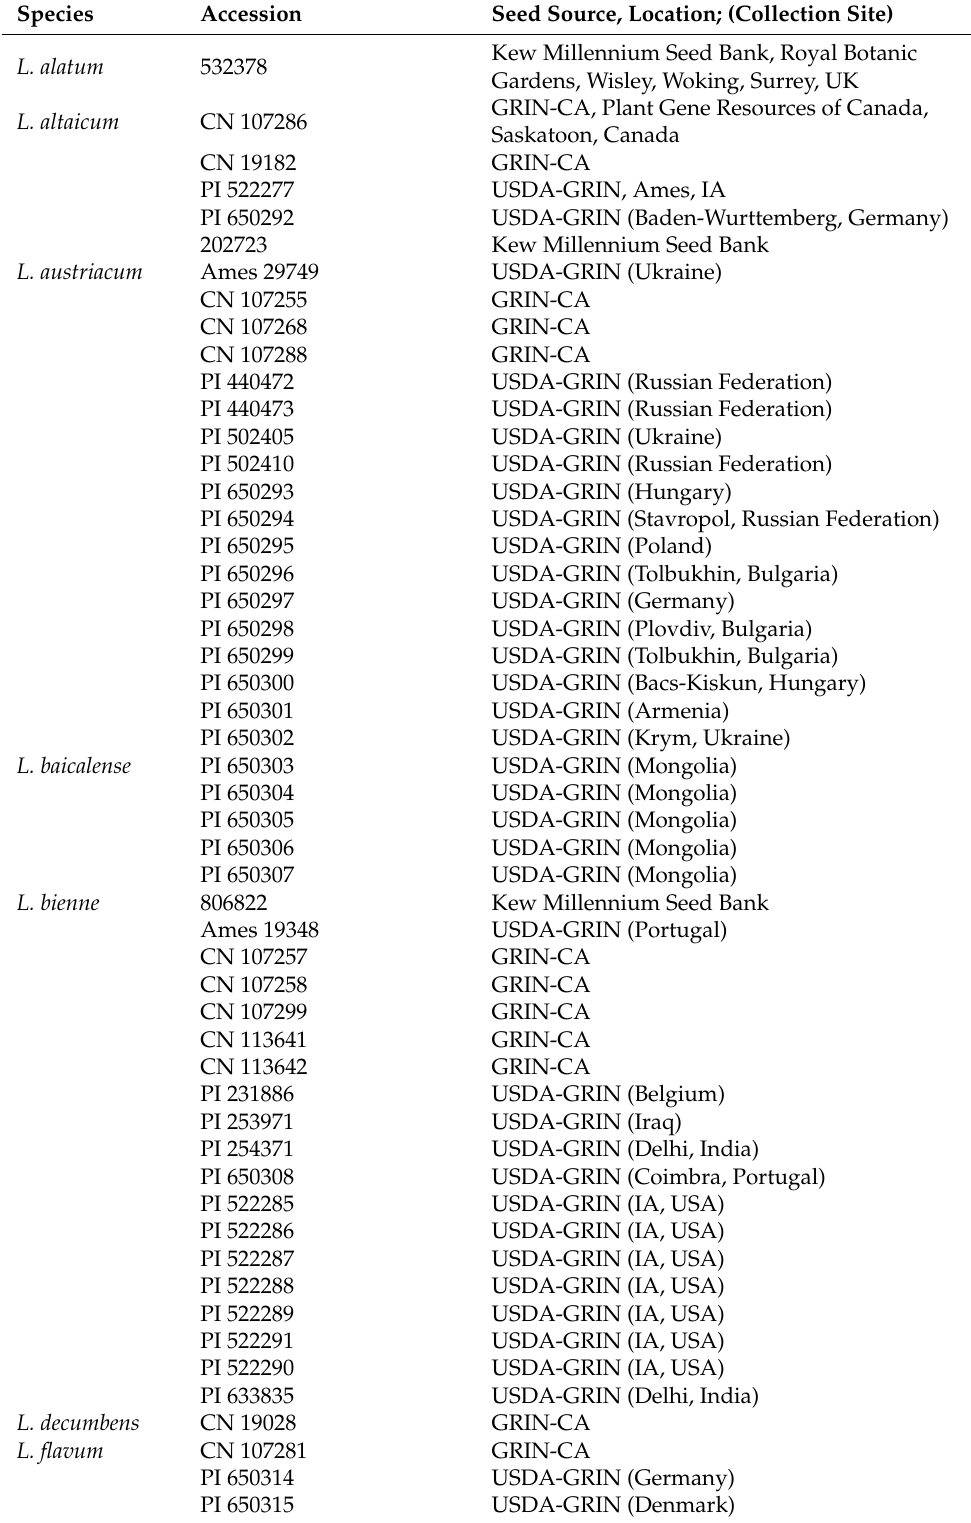
Table 1. Linum species and populations (CFor OS selections), accession code, seed source, location and/or collection site of sources seeds used in the